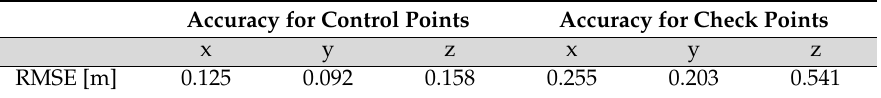
Table 2. The accuracy of aerial triangulation